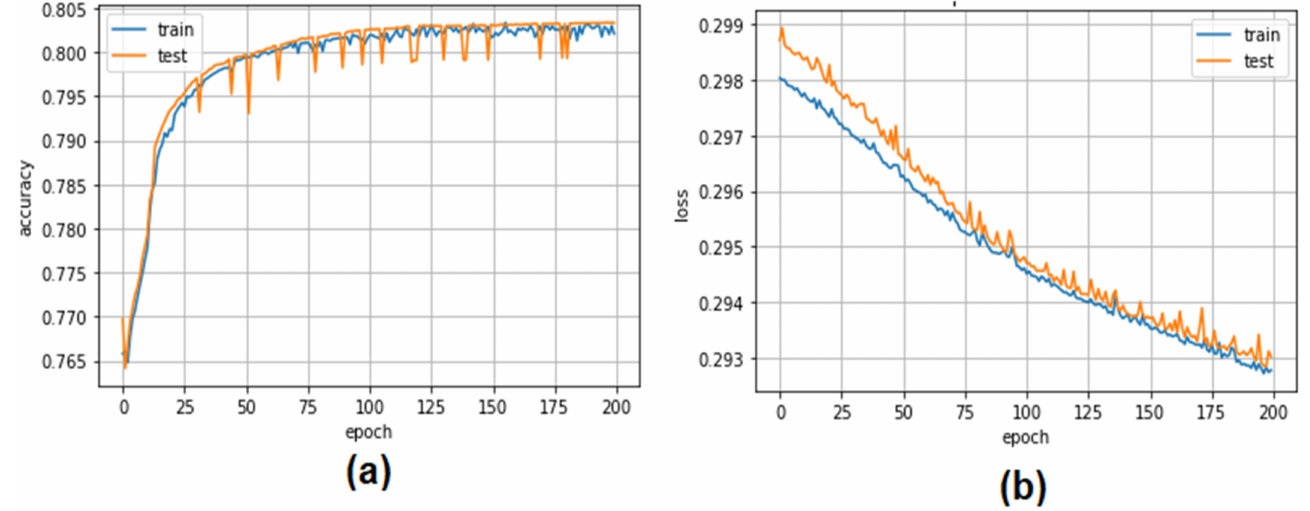
Figure 10. Performance of the CNN model in terms of ( a ) accuracy and ( b ) loss.